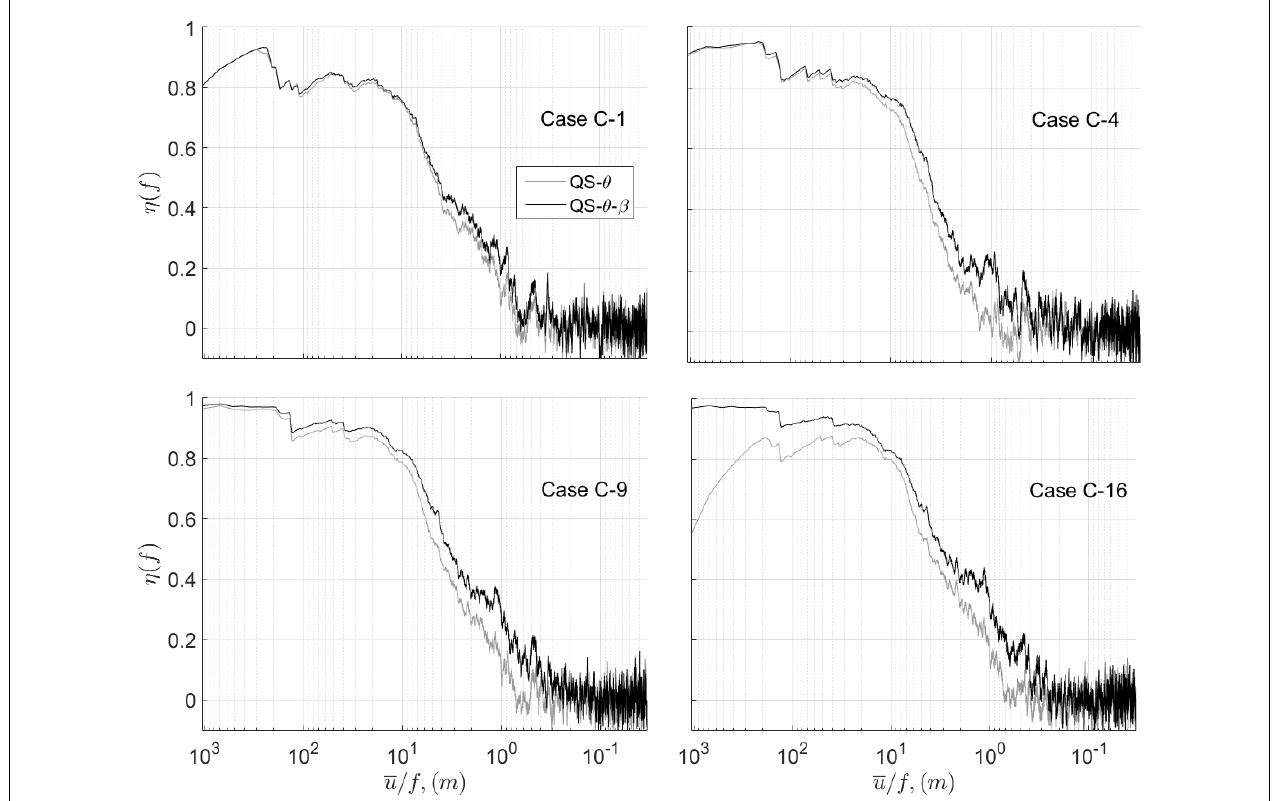
FIGURE 8 | Coherence between measured and QS-predicted C p,t for cases C-1, C-4, C-9, and C-16, mean wind azimuth (cid:22) θ (cid:22) θ (cid:22) θ =